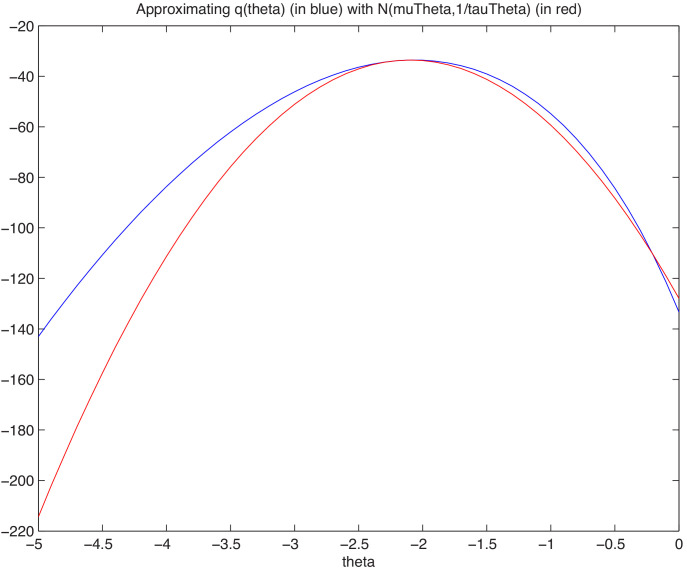
Approximation of theta using Laplace approximation.